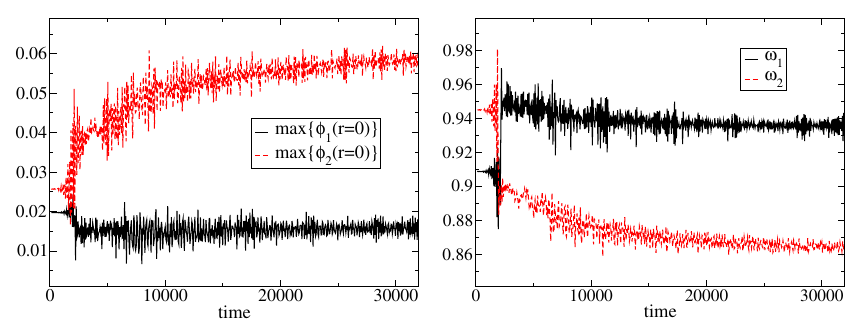
Fig. 10 Left: The maximum of the central value of each of the two scalar fi elds constituting the multi-state BS for the fraction g ¼ 3, where g (cid:2) N ð 2 Þ = N ð 1 Þ de fi nes the relative “ amount ” of each state. Right: The frequencies associated with each of the two states of the multi-state BS. At t ¼ 2000, there is a fl ip in which the excited state (black solid) decays and the scalar fi eld in the ground state (red dashed) becomes excited. Discussed in Sect. 3.7. Reproduced with permission from Bernal et al. (2010), copyright by